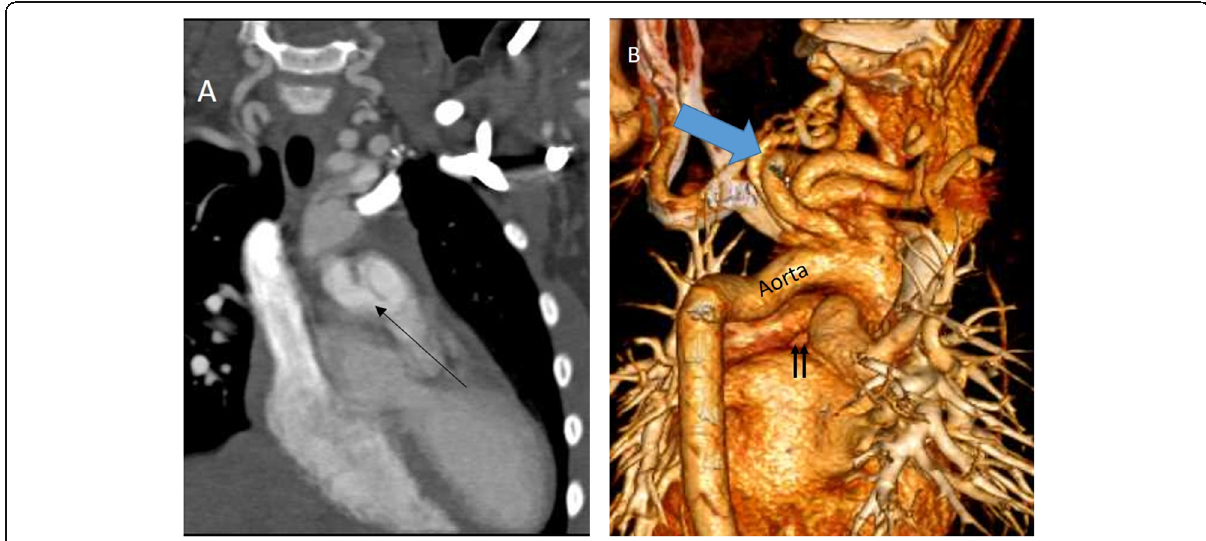
Fig. 4 A 3-year-old boy with arterial tortuosity syndrome. a Coronal CTA shows short MPA with early division into two branches (arrow). b 3DVR: elongated, tortuous aorta and great arteries (blue and black arrows) indicating arterial tortuosity syndrome. Small black arrows indicate the V- shaped appearance of MPA due to early